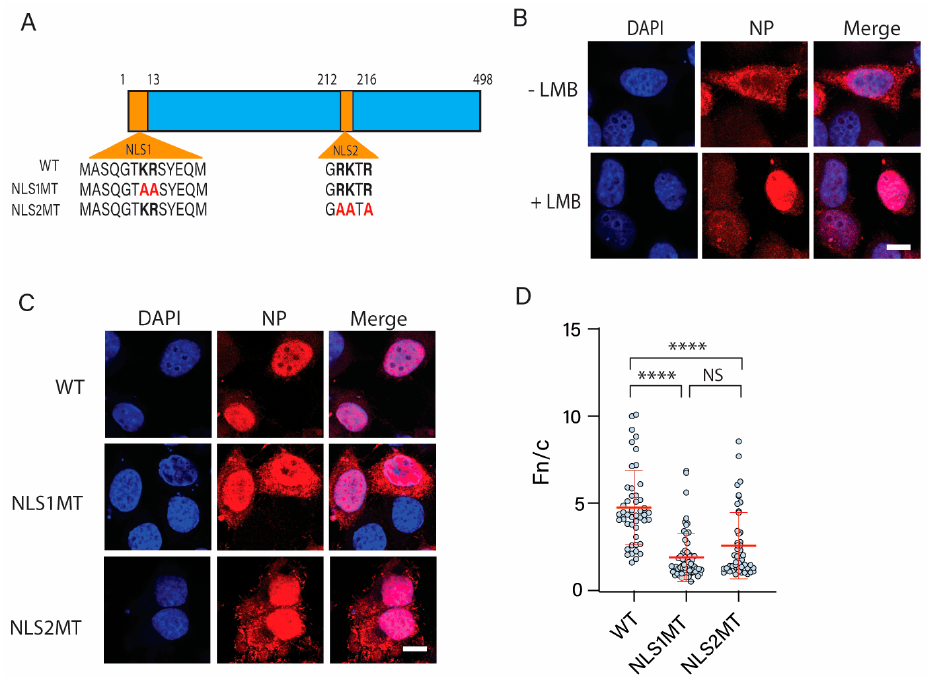
Figure 1. Subcellular localization of WT and mutant NPs. ( A ) Schematic representations of WT NP and its mutants (NLS1 MT and NLS2 MT). Basic residues of NLS1 and NLS2 are indicated in bold. Alanine substitutions of K or R are shown in red. ( B ) Confocal images of HeLa cells transfected with a plasmid expressing WT NP at 30 h post-transfection in the presence or absence of LMB. ( C ) Confocal images of HeLa cells transfected with plasmids expressing WT NP, NLS1, or NLS2 mutant NP at 30 h post-transfection in the presence of LMB. For B and C, LMB was added 12 h post-transfection to inhibit nuclear export of NP. Samples were prepared for indirect immunofluorescence microscopy using an antibody against NP (red), and nuclei were stained with DAPI. Scale bars for ( B , C ), 10 µ m. ( D ) Quantification of the ratio of nuclear to cytoplasmic fluorescence (Fn/c) from the experimental conditions shown in ( C ). Shown is the means ± standard error of the means scored from 85–100 cells for each condition from three independent experiments. (NS, not significant; **** p < 0.0001, Kruskal– Wallis